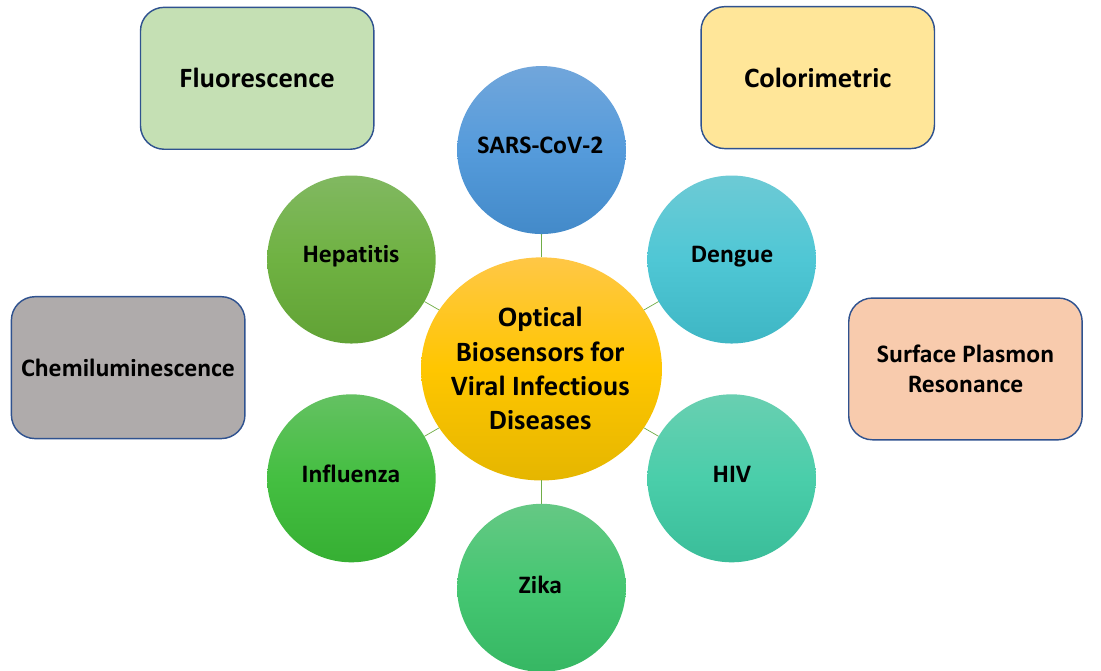
Figure 1. Schematic representation of the optical biosensors in viral infectious disease diagnostics.